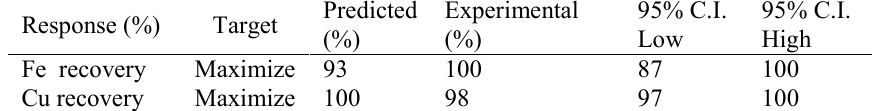
Table 5. Experimental confirmation test at the optimum conditions predicted by the